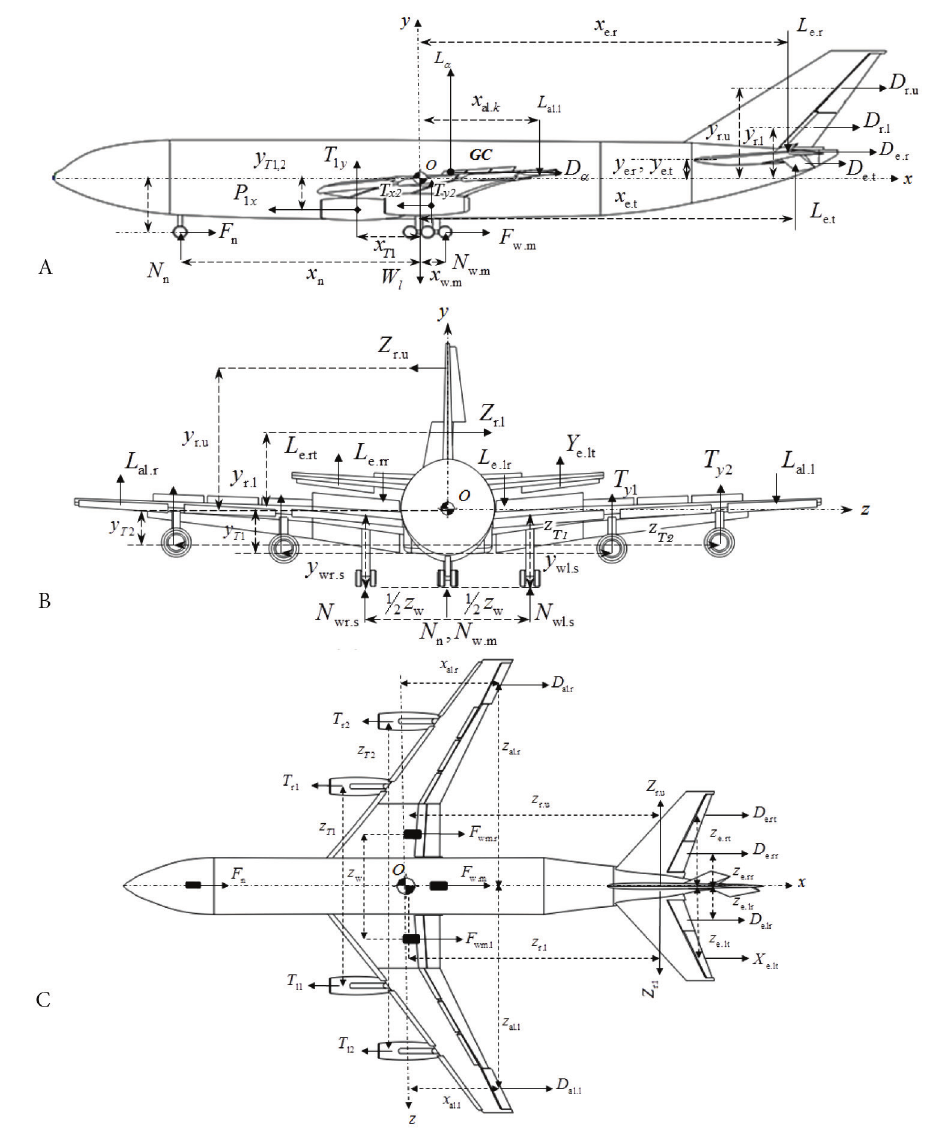
Figure 2. Forces influencing Il-86 during short landing run with symmetrically deflected SR and